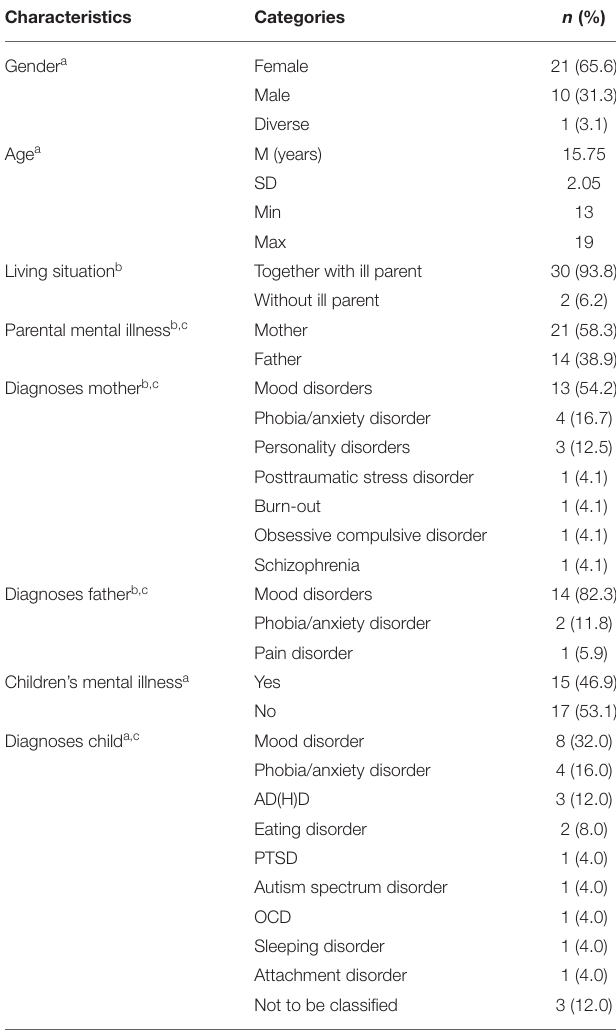
TABLE 1 | Familial and COPMI-specific sample characteristics T1, N =